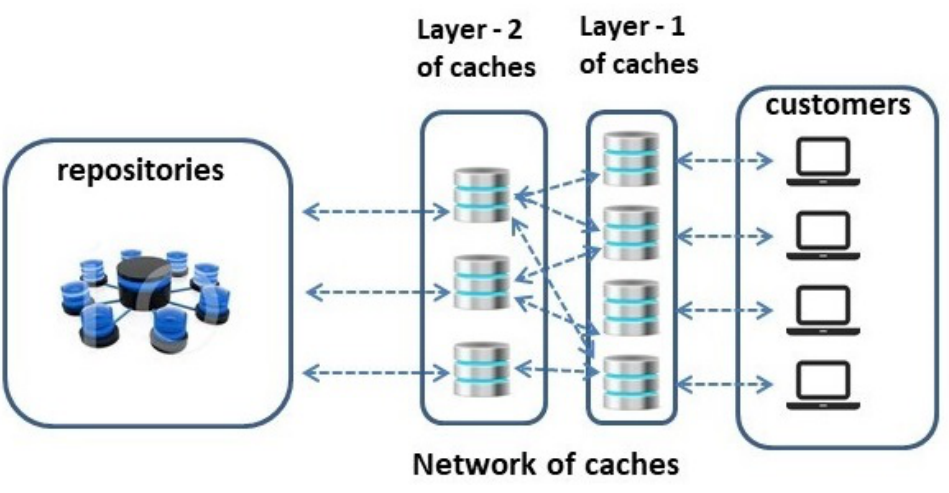
Figure 2. Hierarchy of